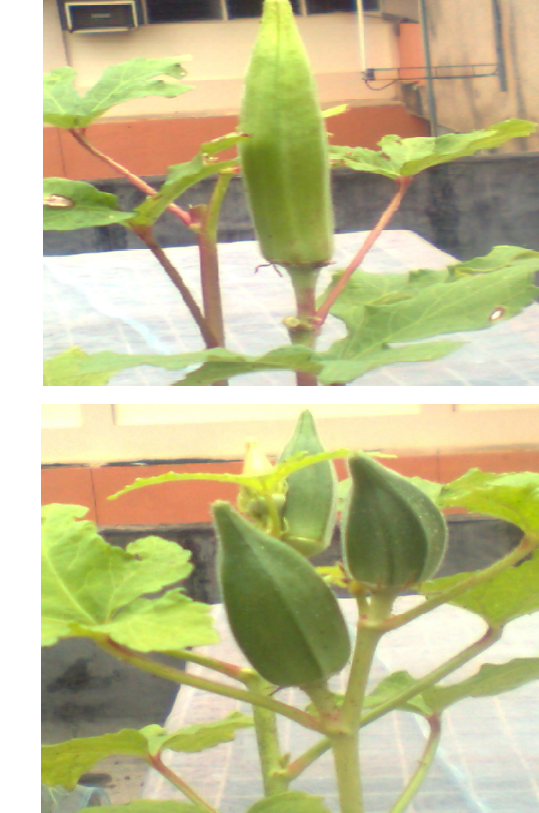
Fig. 1. Two types of okra species used (A) ‘Clemson spine’ and (B)